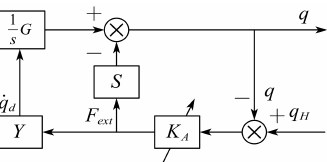
Figure 9. Human–computer interactive admittance control system after linearization